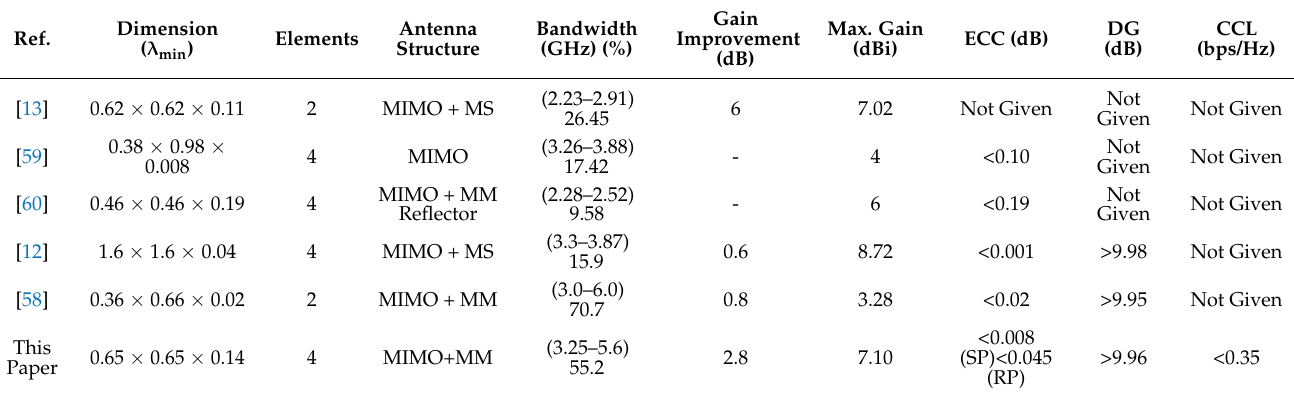
Table 1. Performance comparison with different relevant